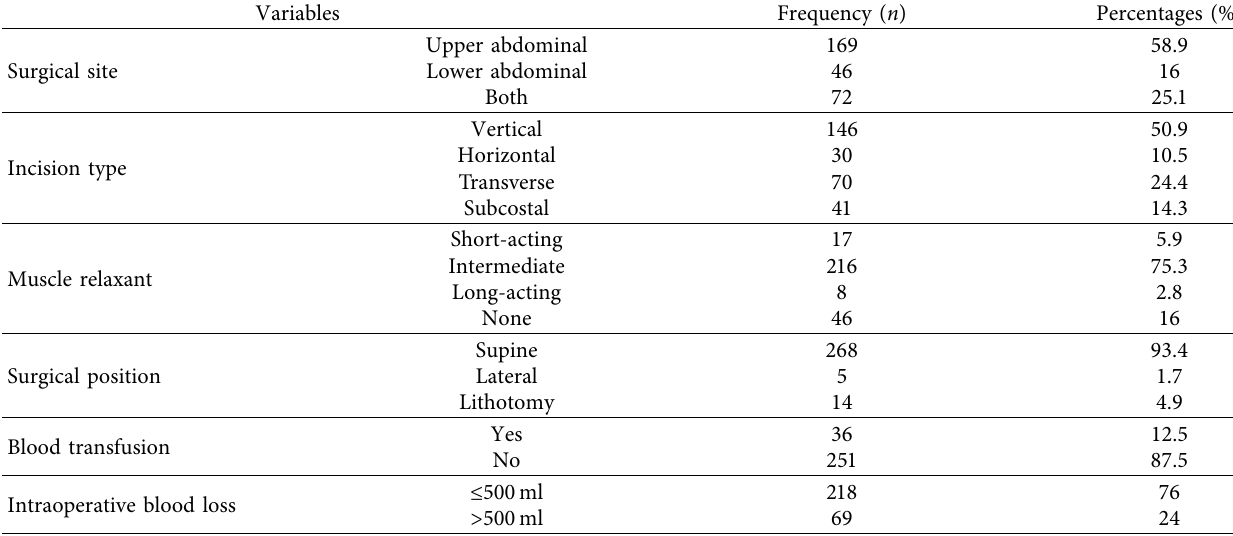
Table 2: Intraoperative anesthesia and surgical factors in patients who underwent abdominal surgery at public hospitals, Ethiopia. Variables